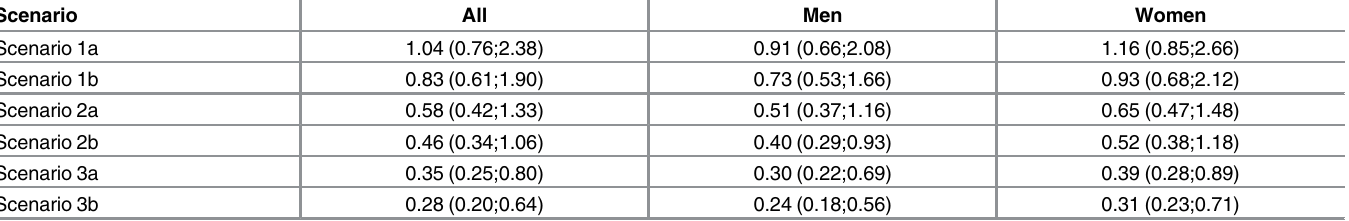
Table 2. Estimated probability of a history of ARF-related VHD in a patient born between 1940 and 1960 presenting with VHD and a history of ben- fluorex intake under the different scenarios. Results are expressed as percent. Estimates are obtained with a probability of VHD in patients treated by benfluorex of 16%, whereas the range obtained with probabilities varying from 7% to 22% are given in parentheses.